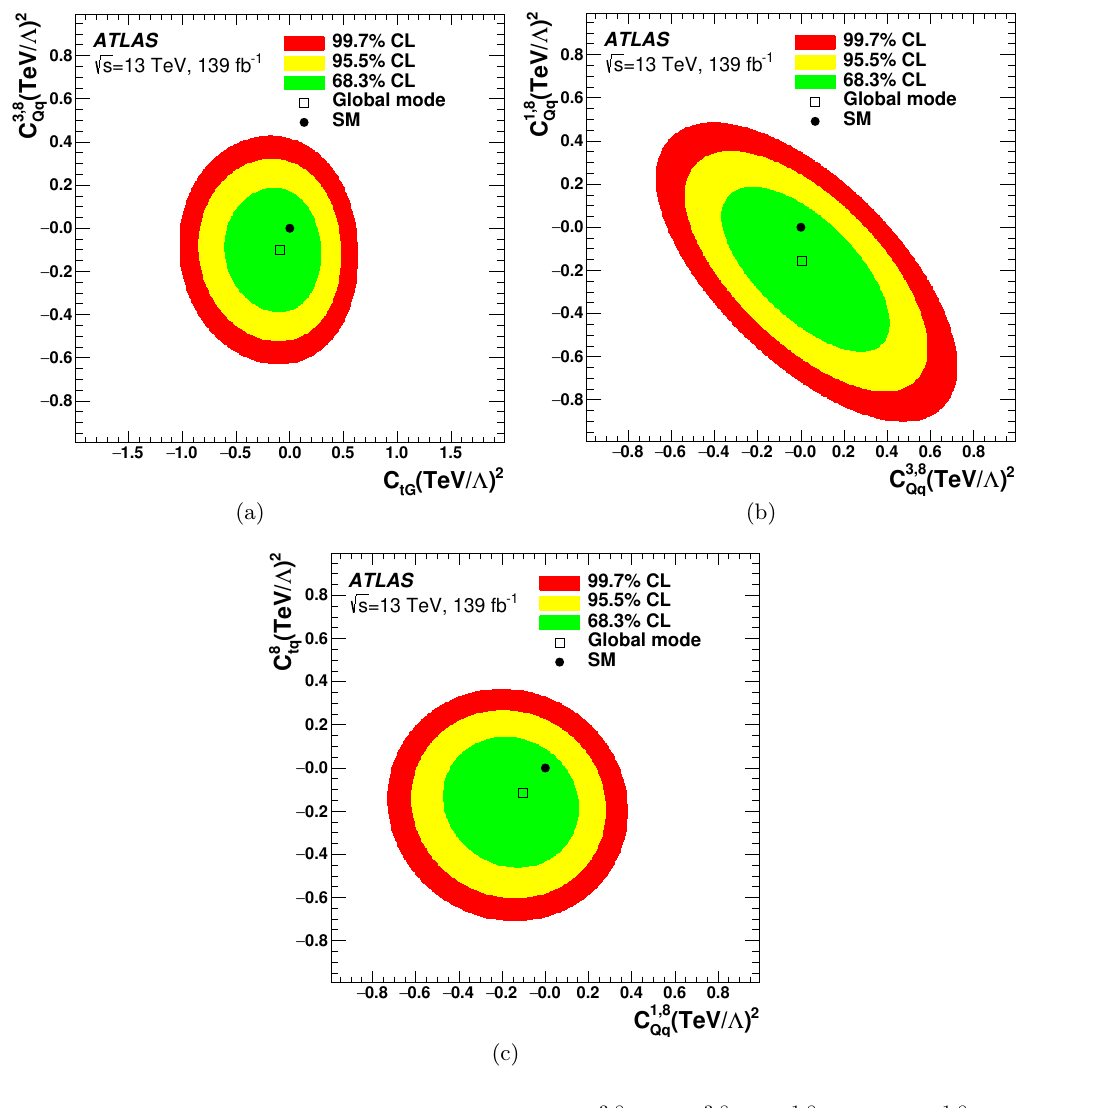
Figure 36 . The two-dimensional limits on (a) C tG vs C 3 , 8 coefficients. Here, C tG is the real part of the Wilson coefficient. The global mode corresponds to the most probable value of the posterior probability